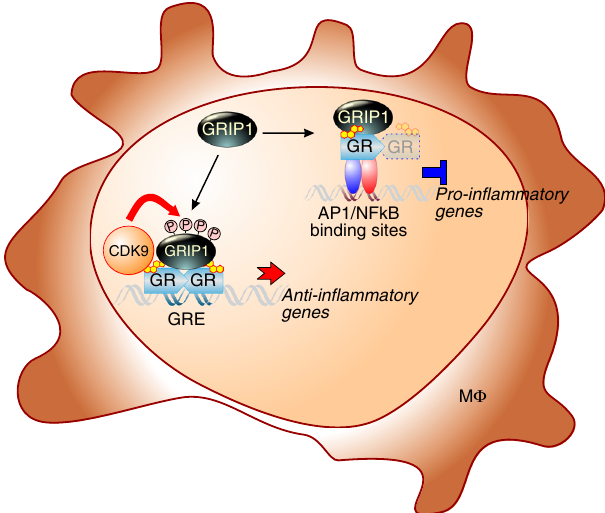
Fig. 7 Differential utilization of GRIP1 phosphorylation at GR-regulated genes. Diagramed is a macrophage (M Φ ) with GR bound at a palindromic GC response element (GRE) activating transcription of anti-in fl ammatory genes or “ tethered ” to AP1 or NF- κ B repressing pro-in fl ammatory genes. GRIP1 is recruited to both types of complexes but undergoes phosphorylation by CDK9 at the palindromic GRE